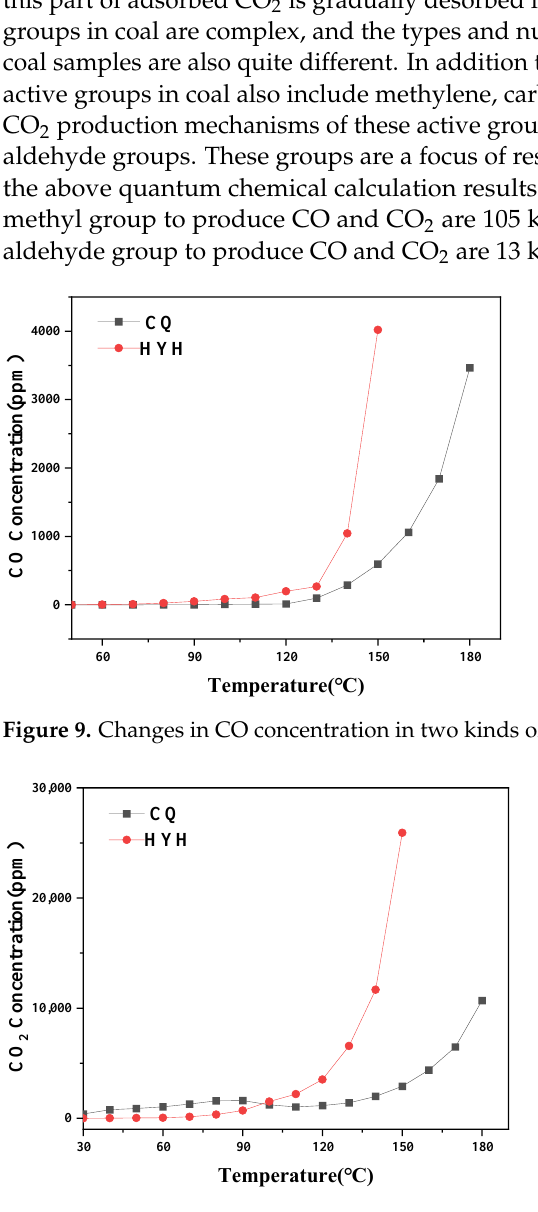
Figure 10. Changes in CO 2 concentration in two kinds of coal samples.